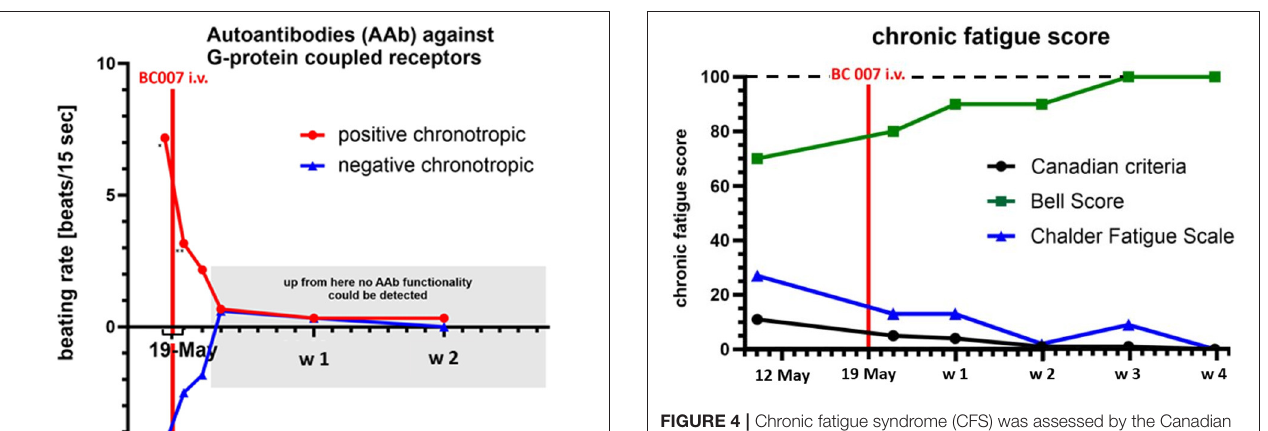
FIGURE 4 | Chronic fatigue syndrome (CFS) was assessed by the Canadian Criteria, Chalder Fatigue Scale, and the Bell Score before and after treatment with BC 007: CFS was reduced after treatment with BC 007, being absent after 4 weeks; the lower is the Canadian Criteria and Chalder Fatigue Scale, the lower is the CFS; the higher the Bell Score, the lower is the CFS; w, week; the range of the scores—Canadian Criteria Score: 0 (best)–34 (worst): Chalder Fatigue Scale: 0 (best)–33 (worst); Bell Score: 100 (best)–0